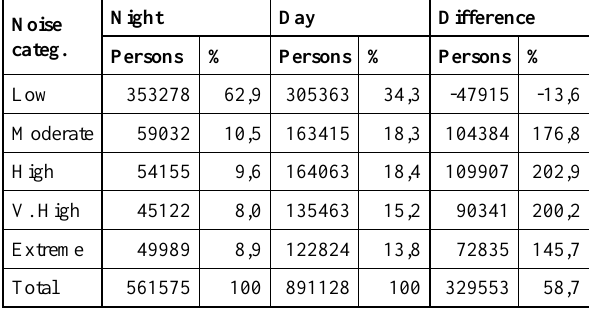
Table 3. Nighttime vs. daytime population exposure to noise in